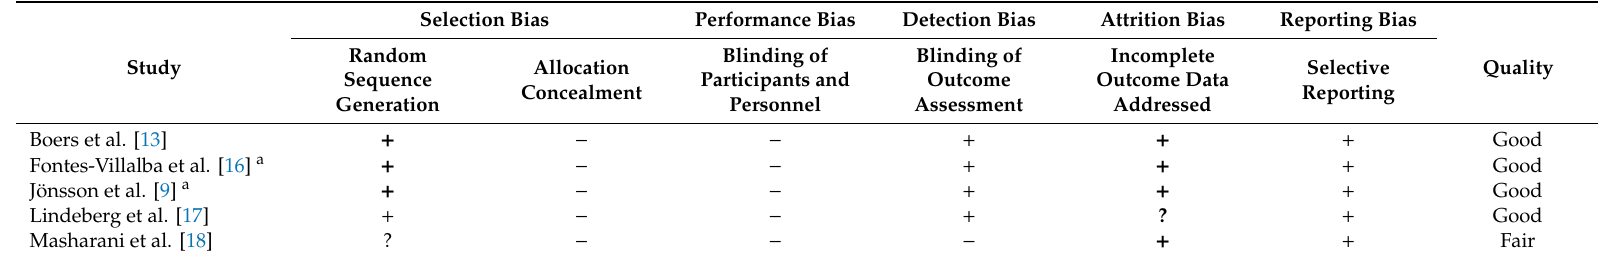
Figure 8. Forest plot comparing AUC 0–120 insulin levels between the diets (favors A—Paleo group; favors B—control group). Table 5. Risk of bias summary according to the Cochrane risk of bias tool.